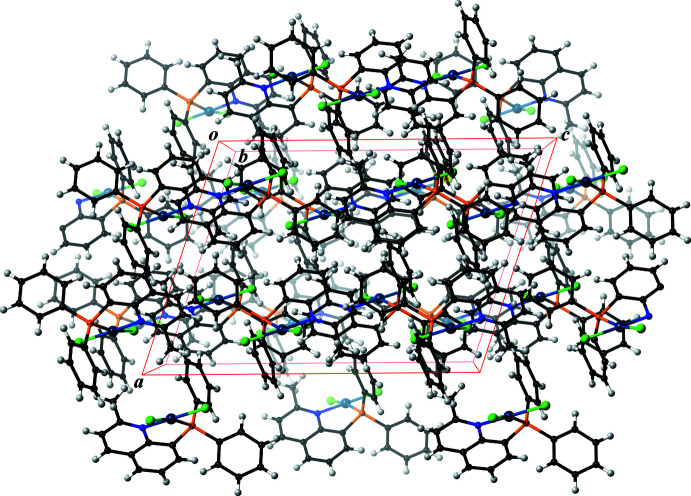
The packing of [PdCl2(PQMe)] (1), viewed along the b axis. Color code: Pd, blueish purple; P, orange; N, blue; C, black and H, gray.